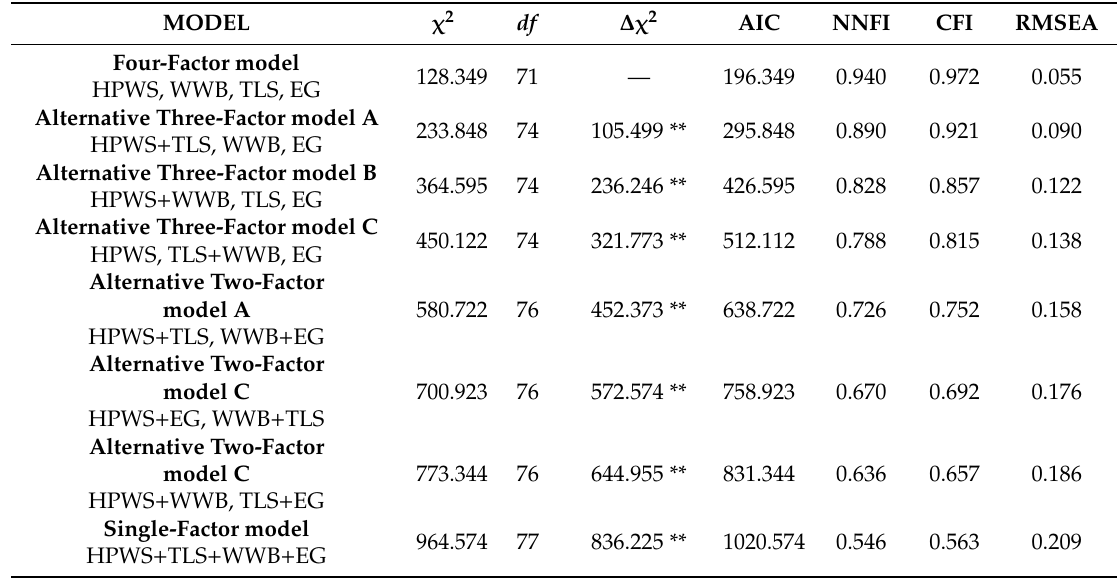
Table 2. Confirmatory factor analysis results of concept discrimination